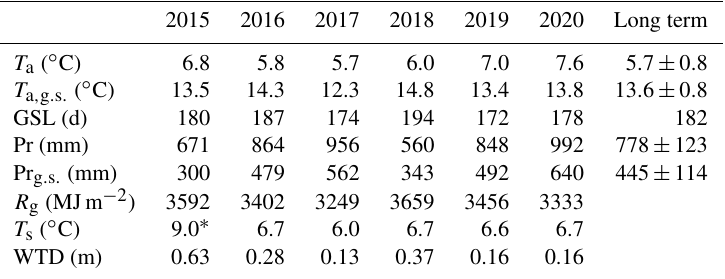
Table 1. Meteorological conditions in the period 2016–2020, with the mean annual air temperature ( T a ), mean air temperature calculated for the long-term growing season (LTGS; 12 April–11 October; T a , g . s . ), and growing season length (GSL) at meteorological station Toropets. The annual sum of precipitation (Pr) and sum of precipitation calculated for the LTGS period (Pr g . s . ) at meteorological station Lesnoy Zapovednik (MS) and the long-term (1991–2020) mean values of T a , T a , g . s . , Pr, and Pr g . s . , with standard deviations ( ± SD), are shown. Annual sums of global radiation ( R g ), mean annual soil temperature ( T s ) at 5cm depth, and mean annual water table depth at paludified forest (PF) are shown.